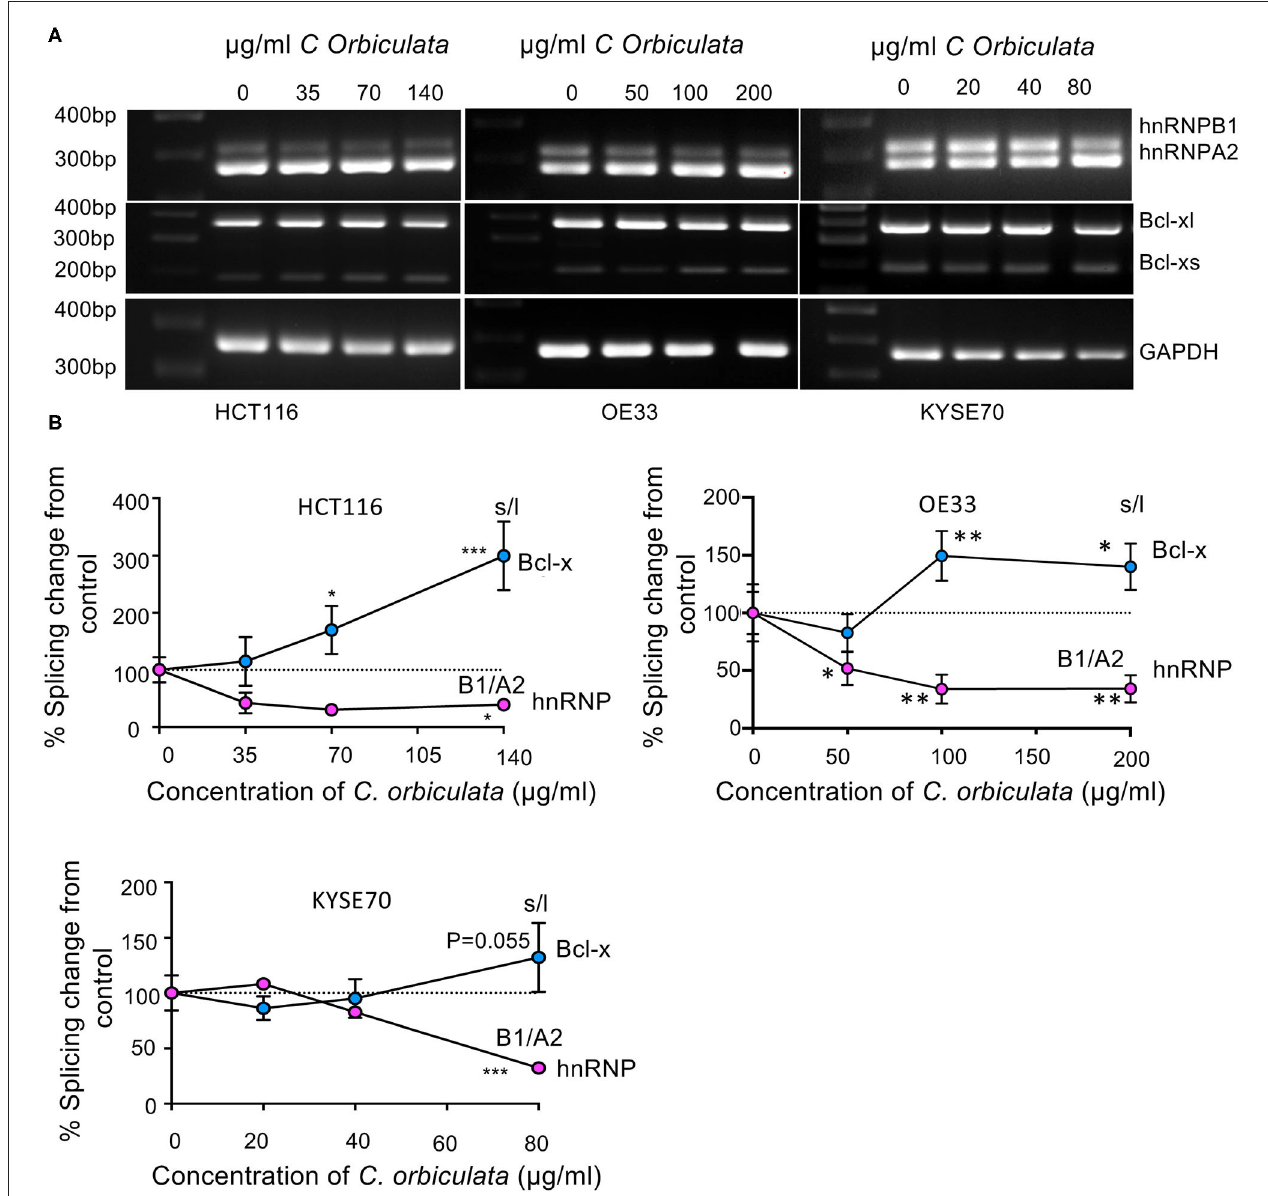
FIGURE 3 | Effects of C. orbiculata on splicing of hnRNPA2B1 and BCL2L1 in HCT116, OE33 and KYSE cancer cells. (A) RT-PCR images and (B) quantitative analysis of PCR results. Percentage changes in ratio of hnRNPA2B1 and Bxl-xl/s from control. GAPDH was used as a loading control. Quantification demonstrates a decrease in hnRNPB1, and an increase in Bcl-xs. n = 3, mean ± SEM ( n = 3). * P < 0.05, ** P < 0.01, *** P < 0.001, **** P <